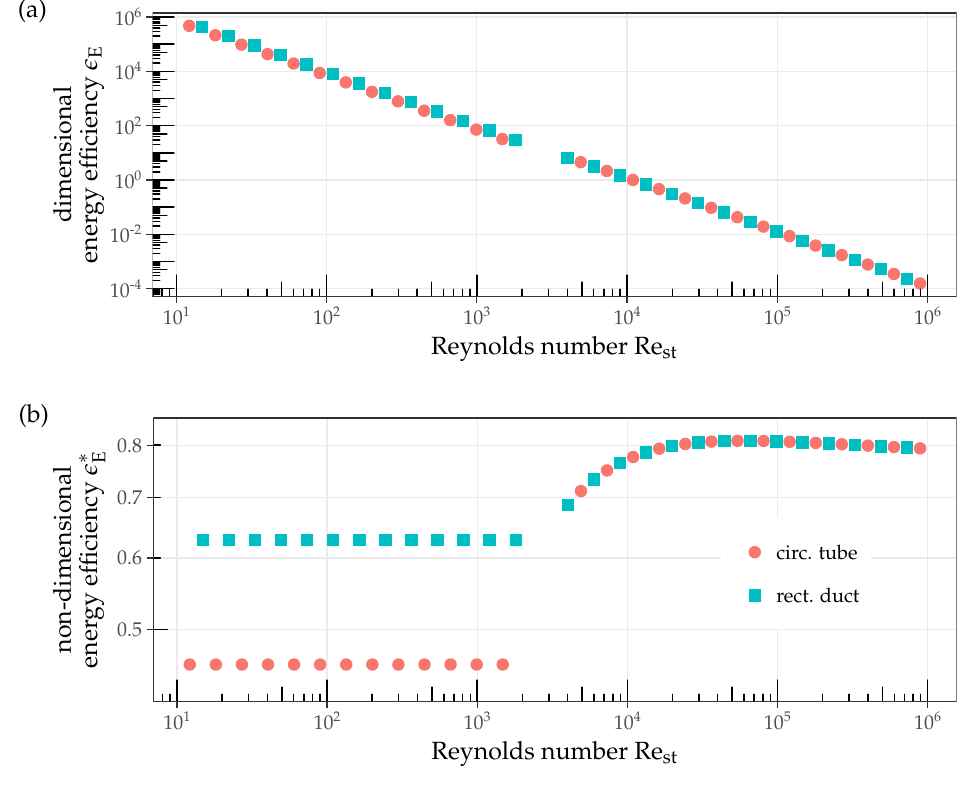
Figure 1. Dimensional ( a ) and non-dimensional ( b ) energy efficiency (cid:101) E and (cid:101) ∗ Reynolds number Re st for a fully developed laminar and turbulent flow in a smooth circular tube and a rectangular duct; air is used in (a) as fluid at 25 ◦ C and 1 atm with a hydraulic diameter of 5mm; the transition flow is not shown. Data is based on